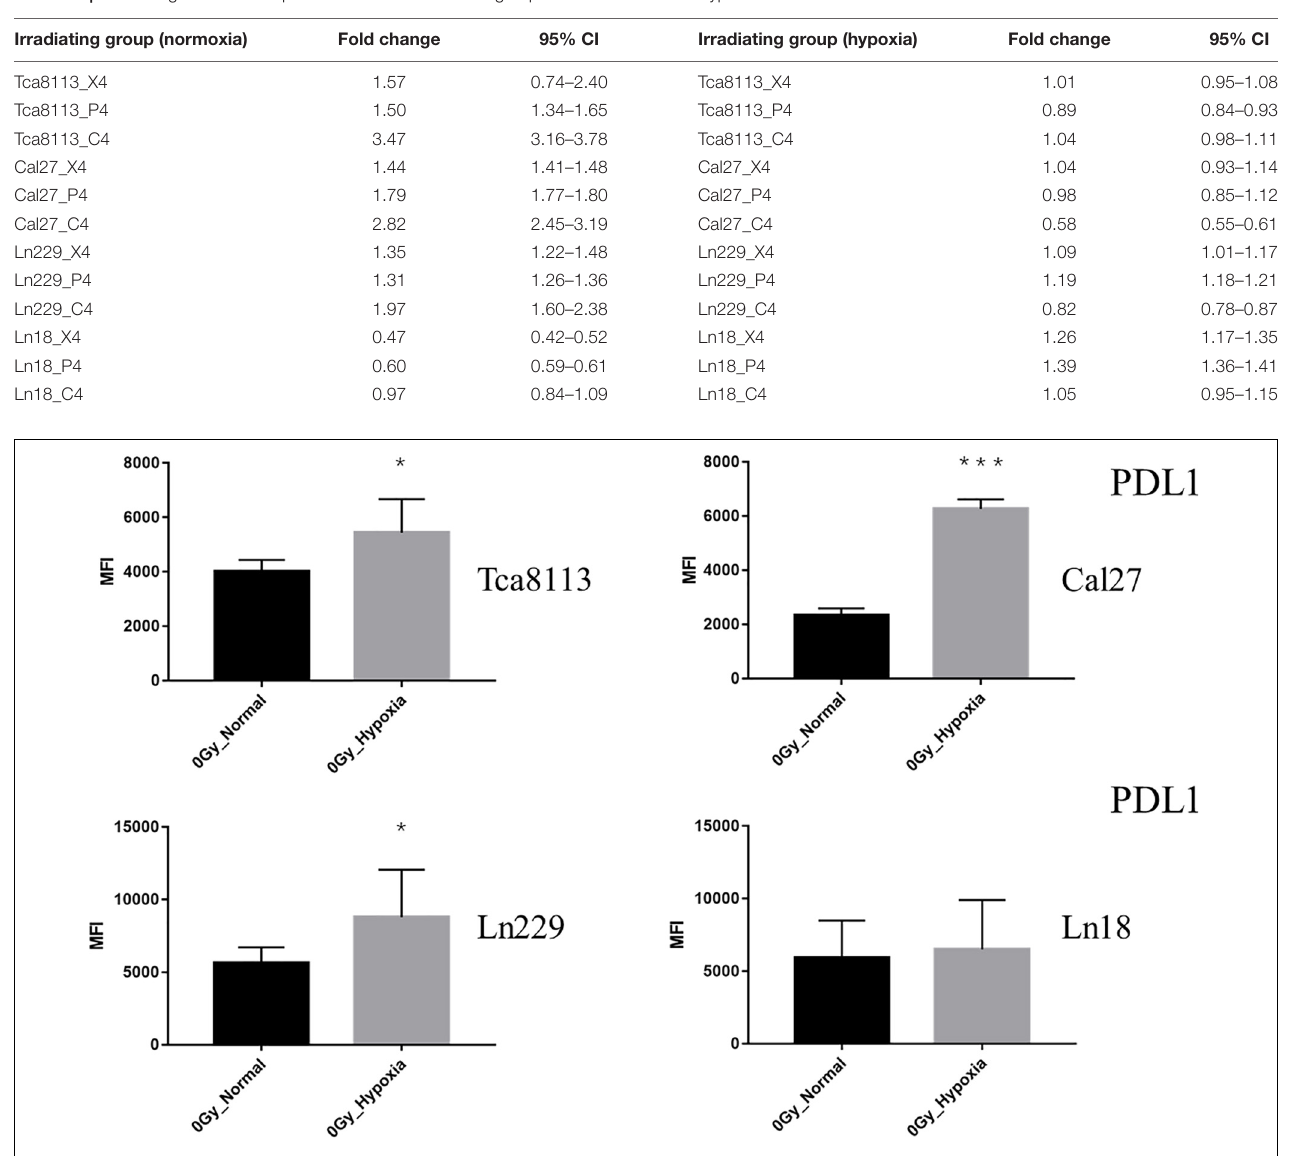
FIGURE 6 | Comparison of baseline PDL1 expression under normoxia and hypoxia. The expression of PDL1 on the tumor cell surface was detected by flow cytometry. The MFI of each tumor cell line under normoxia and hypoxia is shown in the histogram. Results are presented as mean ± s.d. Each experiment was repeated at least three times. Statistical significance of the difference between cells under normoxia and hypoxia are indicated by asterisks. * p < 0.05, *** p <